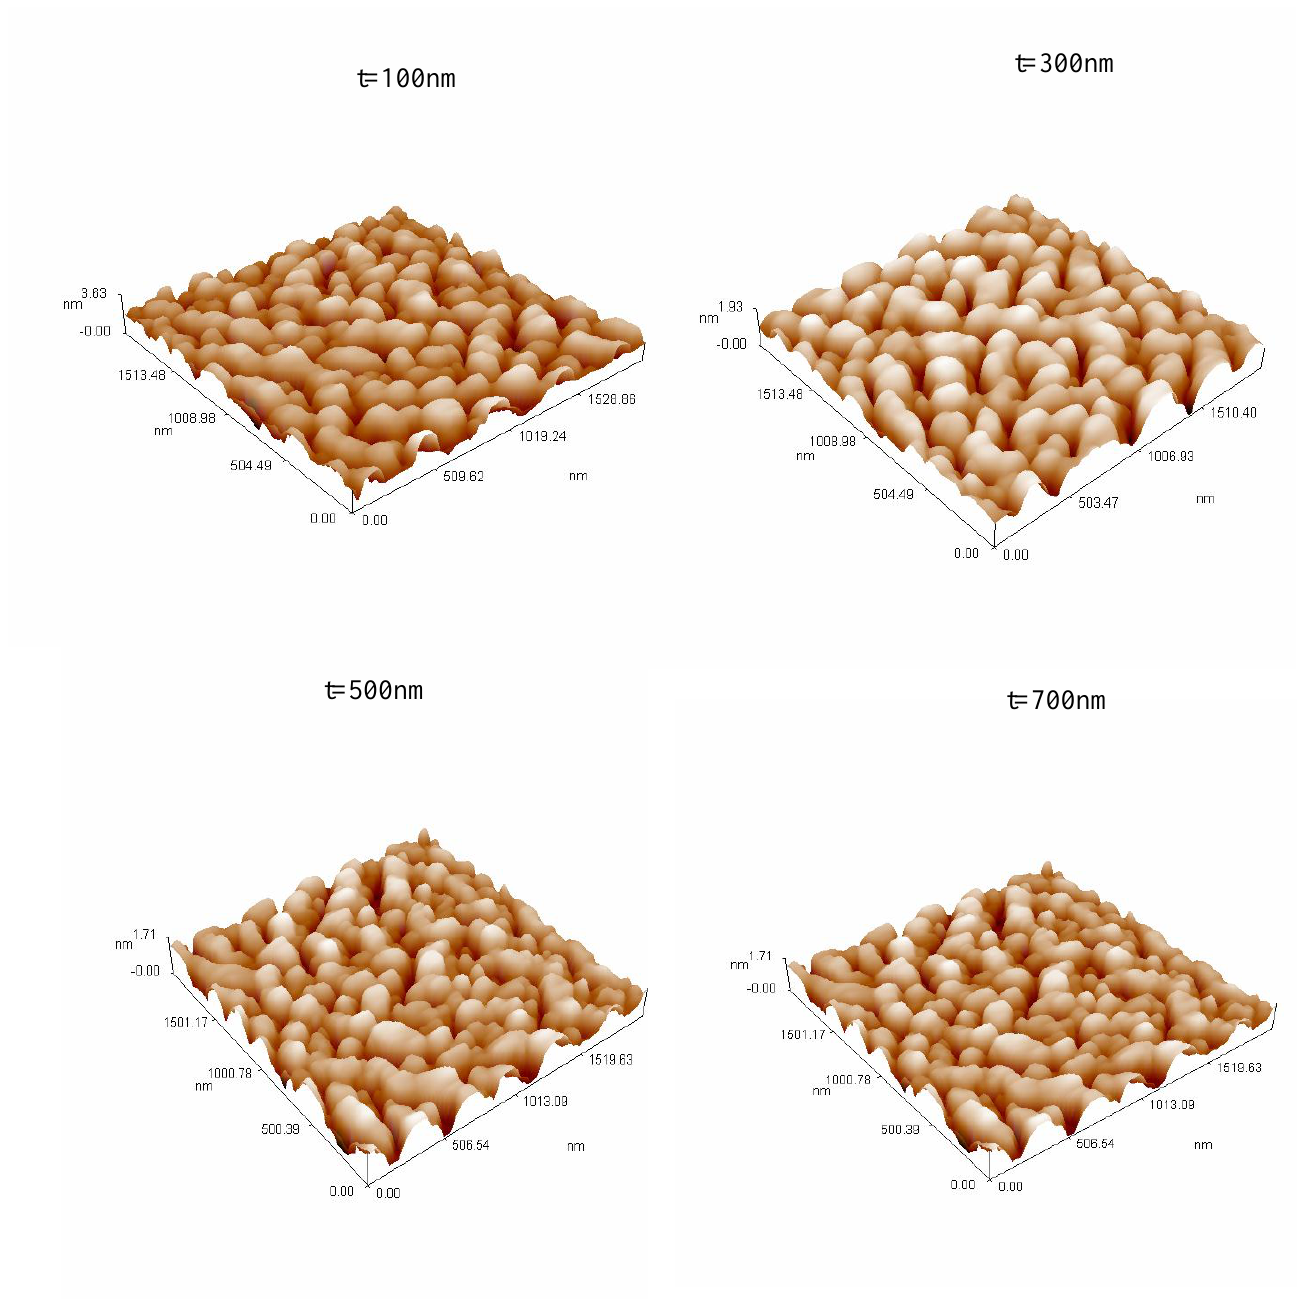
Fig. 2: AFM images for Bi